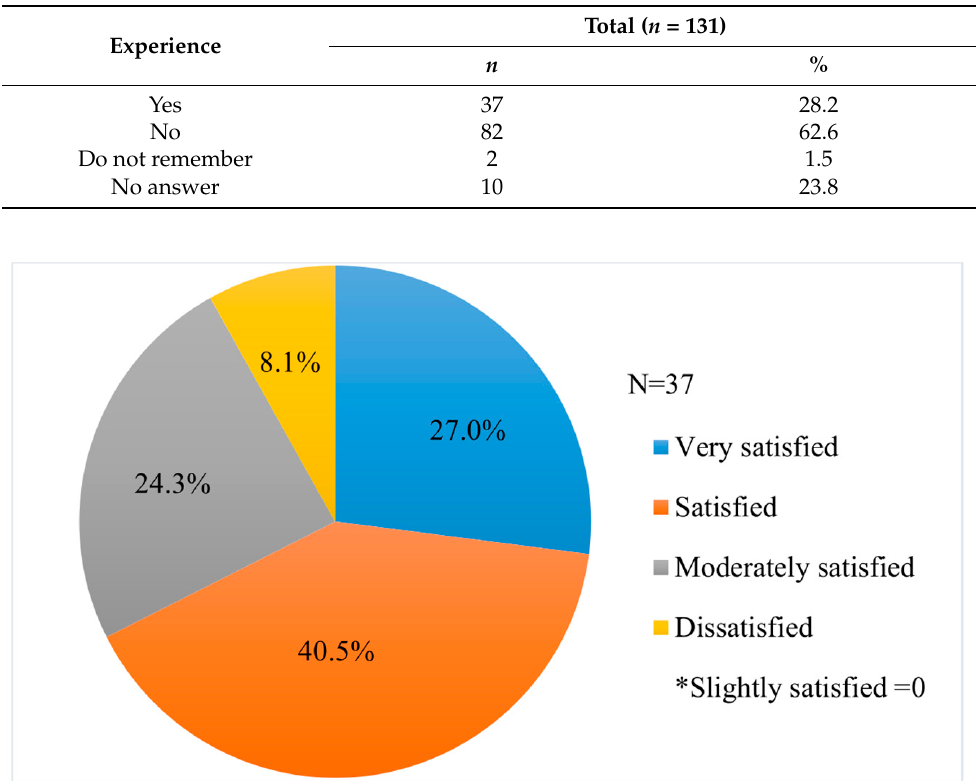
Table 2. Experience receiving education about safe medication use.